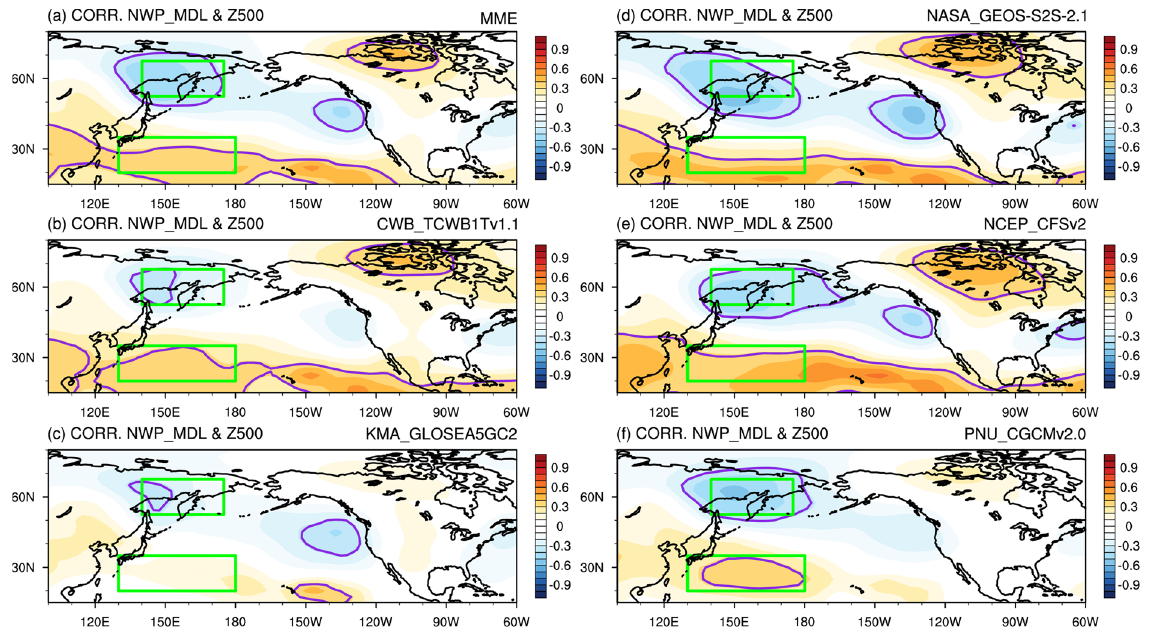
Figure 13. Correlation patterns between Z500 and the NWP index predicted by ( a ) MME and ( b – f ) individual models. Green boxes enclose the areas of Z500 averaging used for the estimation of the WP index. Significant at the 95% confidence level values are enclosed by a thick line.